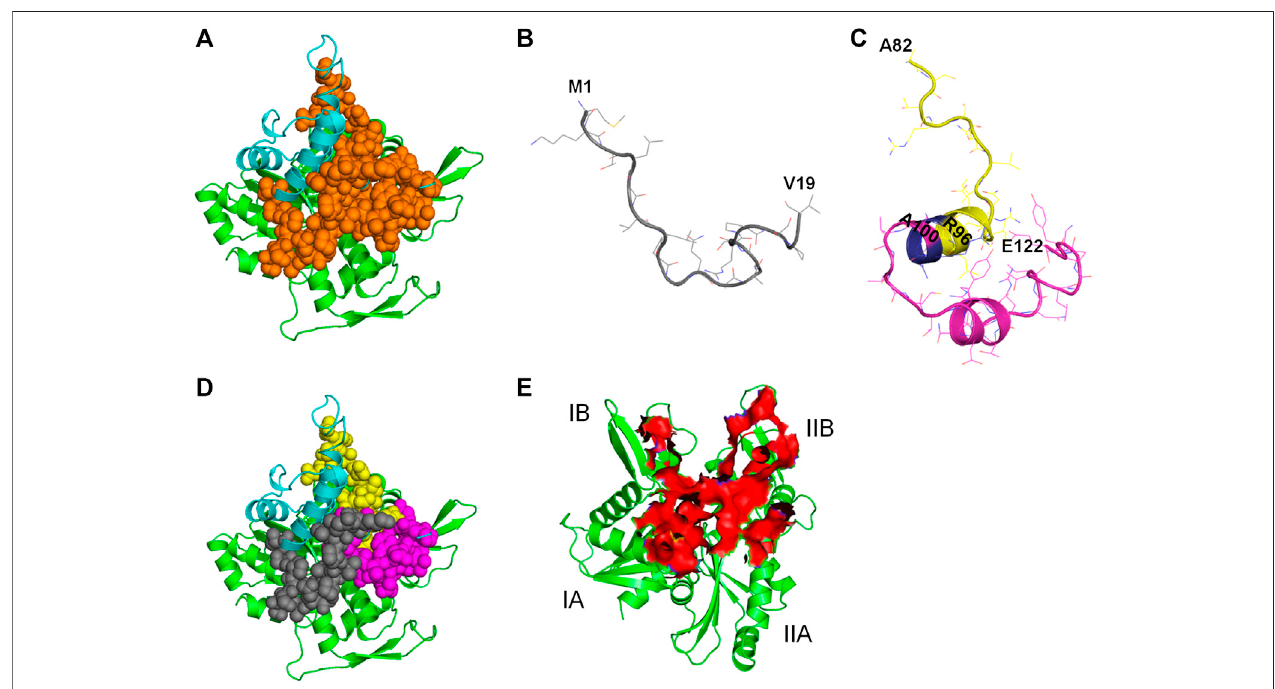
FIGURE 11 | Illustration of antiMreB peptides design possibilities. Carbon atoms of MreB are shown in green. Carbon atoms of CbtA are colored in cyan. (A) Illustration ofthe polypeptide unit formed by the 8 predicted peptides on the interproto fi lament interface of MreB. Orange spheresrepresent the continuous polypeptide unit formed bythe eight predicted peptidesinCbtA. (B) TheM1-V19segment. (C) The A82-R96 and A100-E122 segments shown in yellow and magenta, respectively. BlueshowstheA97-R98-R99tripeptideseparatingthetwosegments. (D) IllustrationoftheM1-V19(gray),A82-R96(yellow),andA100-E122(magenta)segments on the interproto fi lament interface of MreB. (E) Predicted region of MreB that harbors the hotspots for antibacterial peptides